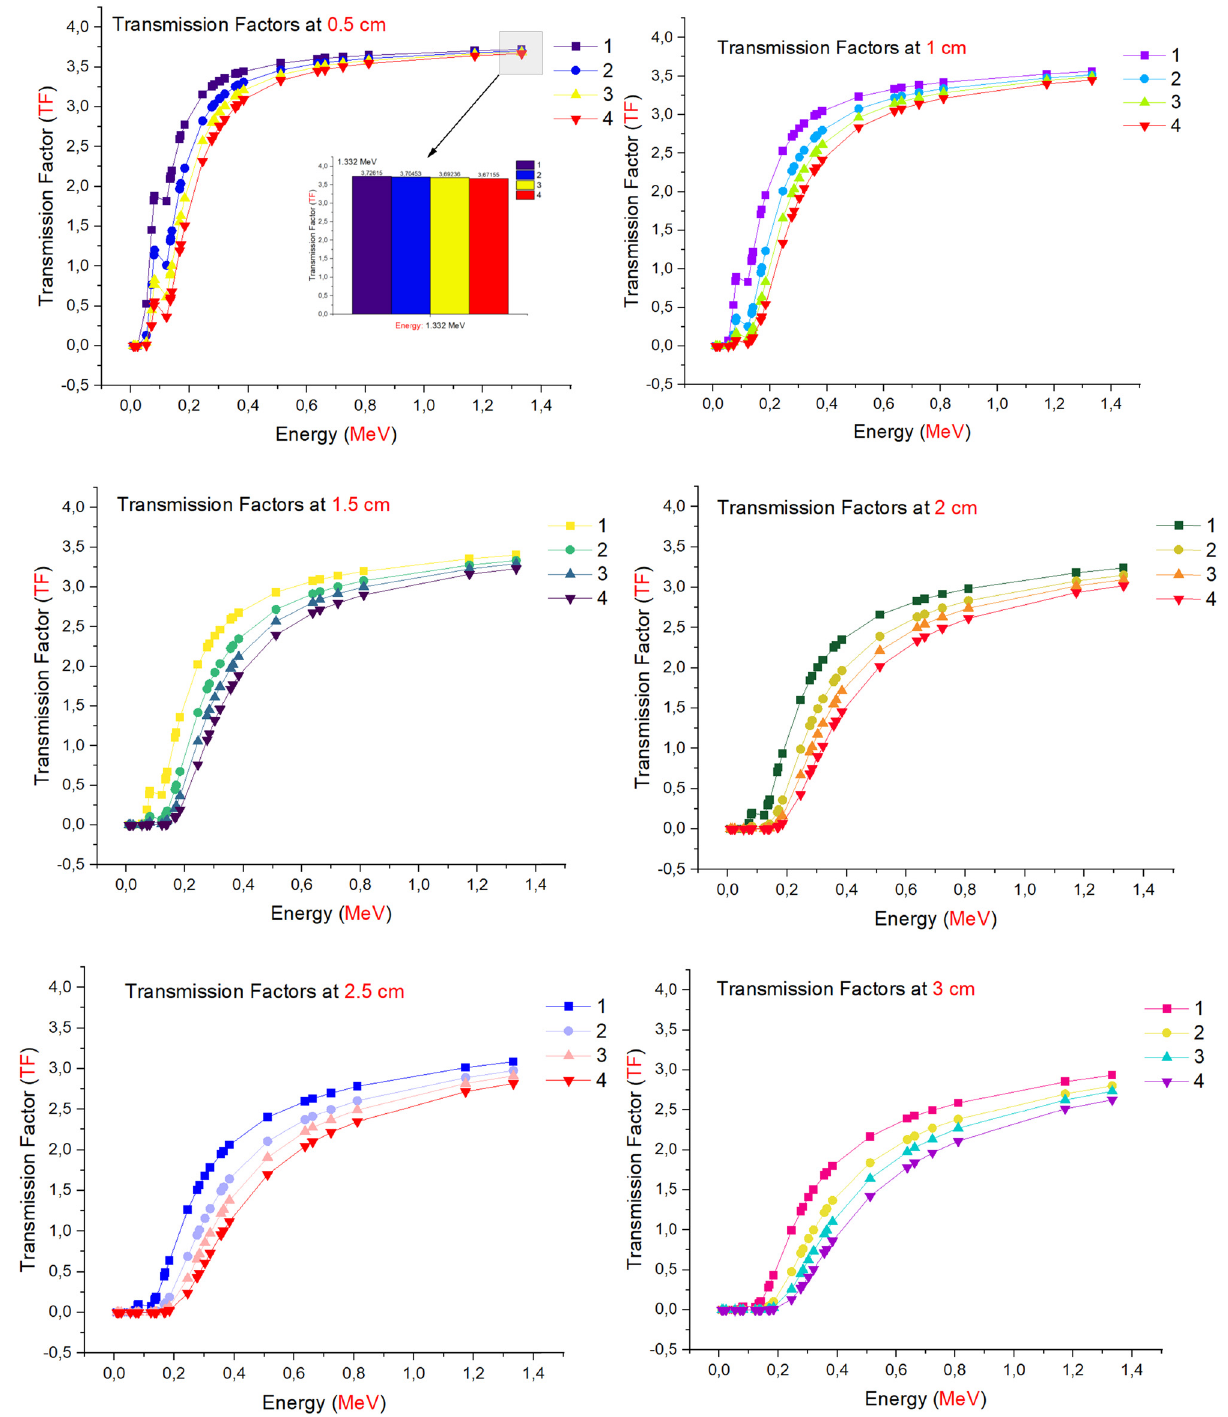
Figure 16: Comparison of the TFs as a function of used radioisotope energy ( MeV ) for di ff erent glass